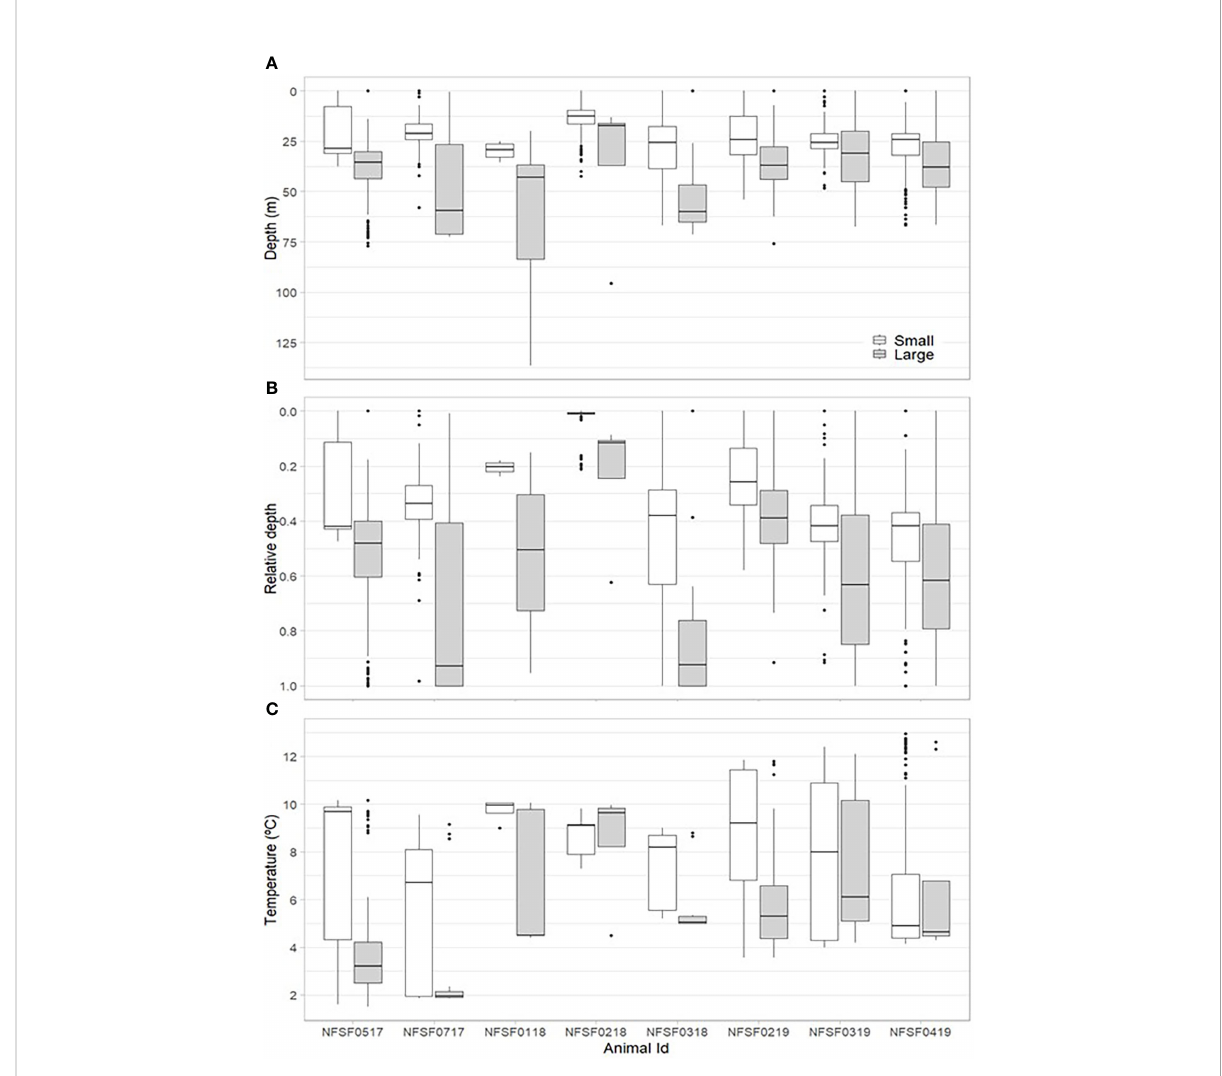
FIGURE 4 Boxplots depicting the depth (m, A ), relative depth (depth/sea fl oor depth, B ), and temperature (°C, C ) where successful prey captures occurred for each fur seal by prey size (white= small, grey= large). Lines denote the median values, boxes encompass the fi rst and third quartiles, points are outliers (> 1.5 * the inter-quartile range), and whiskers display the smallest or largest values beyond the inter-quartile range, excluding